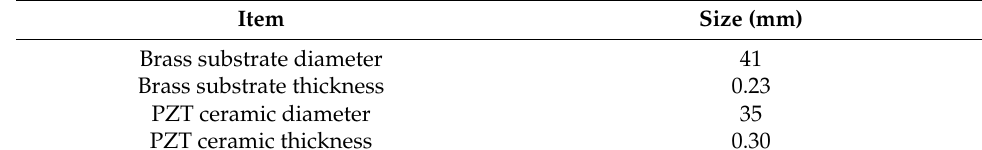
Table 2. The size parameters of the piezoelectric (PZT) vibrator.